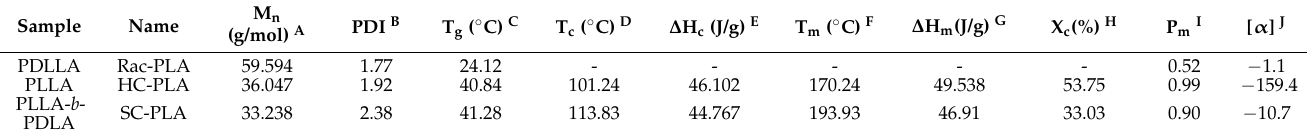
Table 1. Bulk polymer